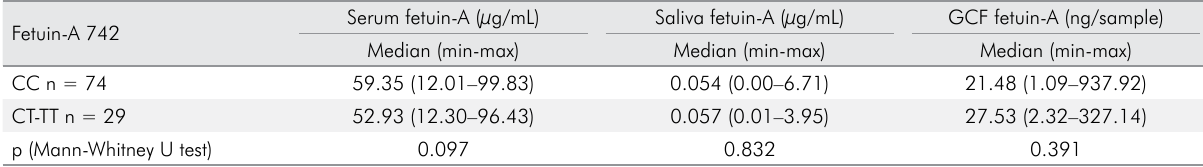
Table 3. Median, minimum and maximum levels of fetuin-A in serum, saliva and gingival crevicular fluid (GCF) of patients according to fetuin-A 742 genotypes.